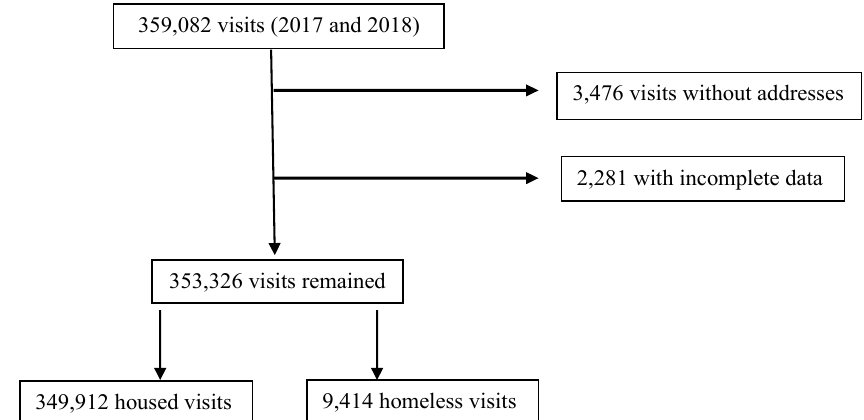
Figure. Flow chart of eligible total